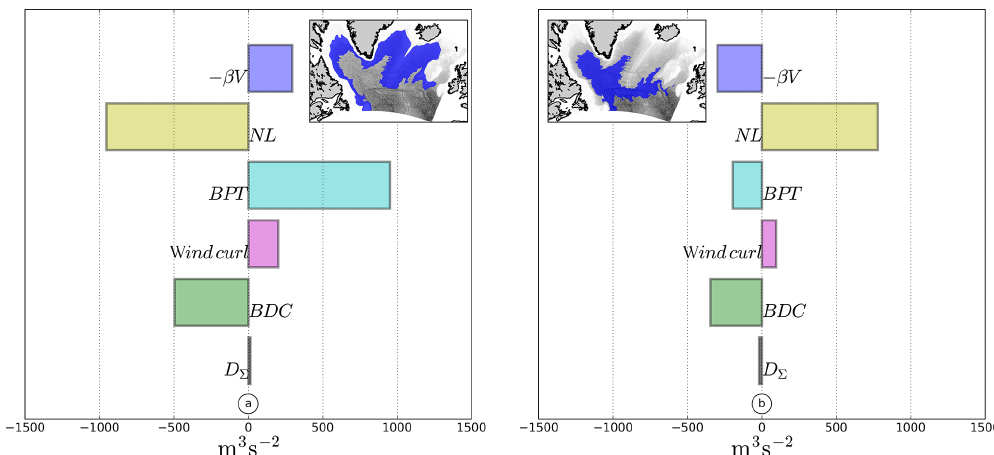
Figure 10. Integration of the barotropic vorticity terms in the slope area ( a , defined between the barotropic stream function contour − 3Sv and the 3000m isobath) and interior (b)